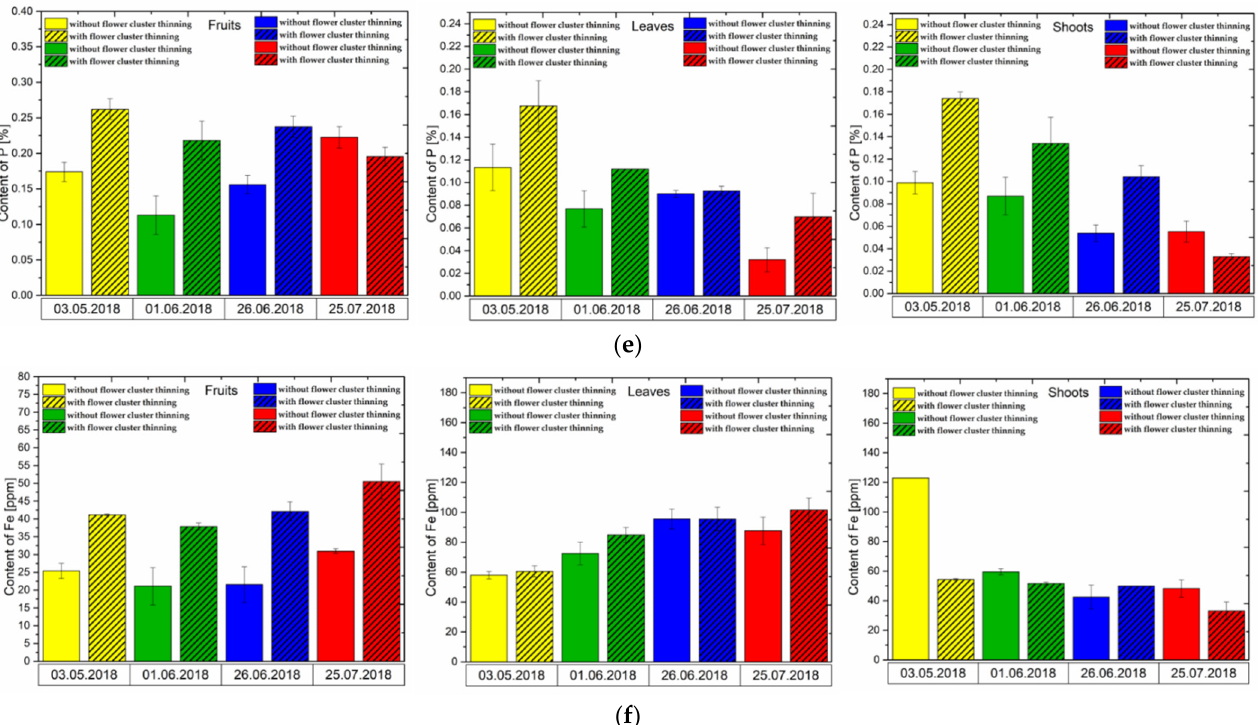
Figure 8. Cu ( a ), Mg ( b ), Mn ( c ), N ( d ), P ( e ) and Fe ( f ) in Organs of Pistachio Trees With or Without Flower Cluster Thinning Application.